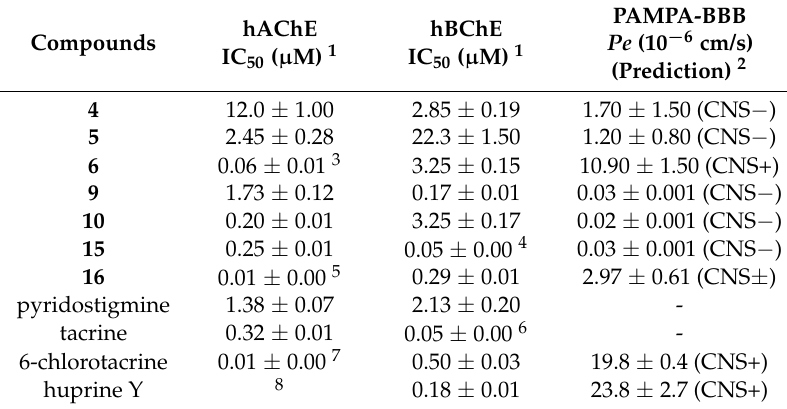
Table 1. hAChE and hBChE inhibitory activities and PAMPA-BBB permeabilities of the target and reference